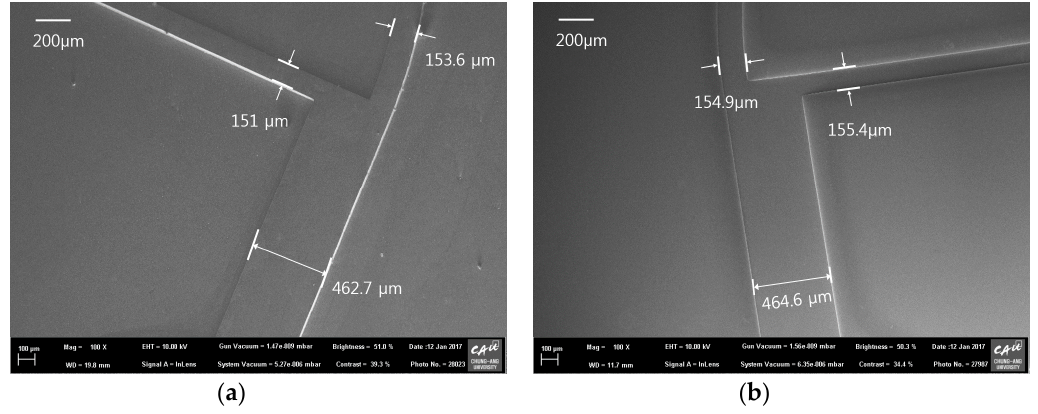
Figure 4. SEM images of fabricated ( a ) AC mold and ( b ) glass molded microchannel at blood separation region.